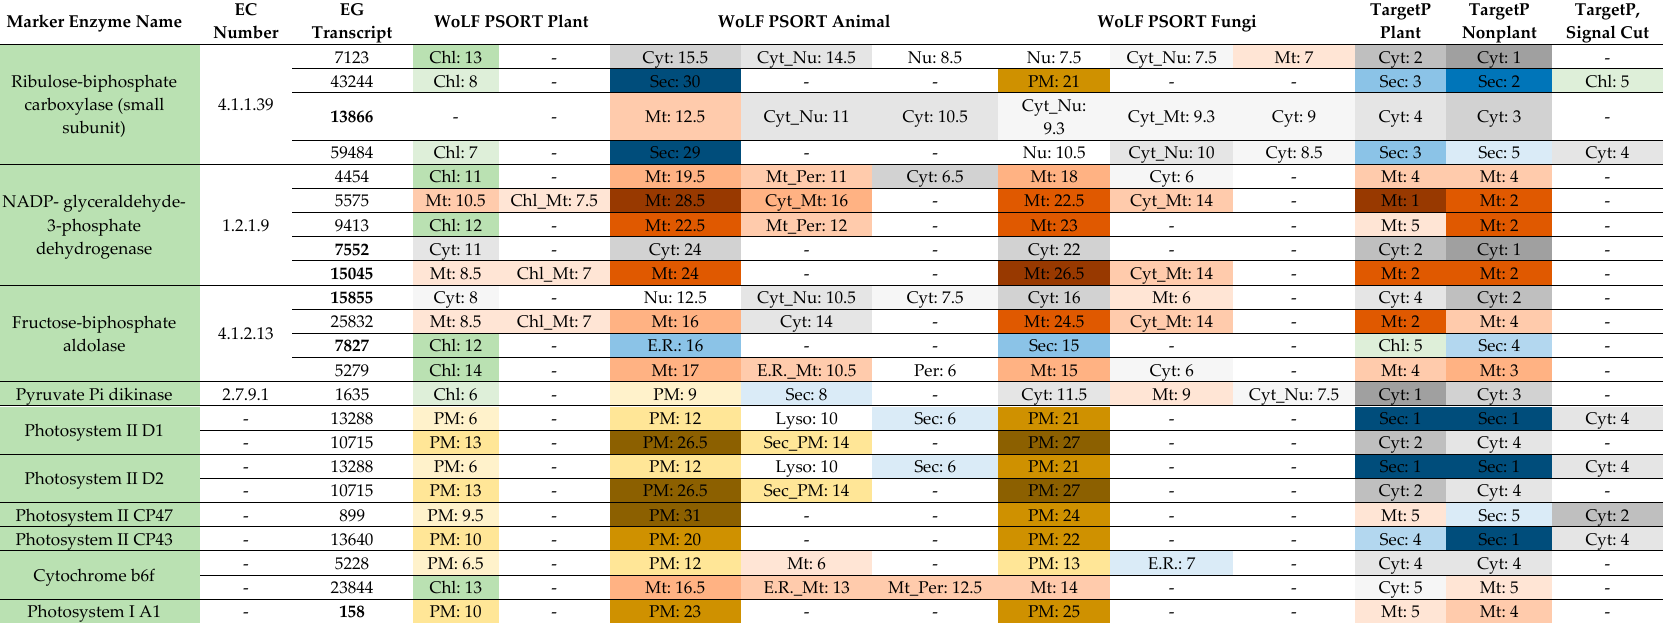
Table 3. Subcellular location prediction of E. gracilis chloroplast marker proteins.